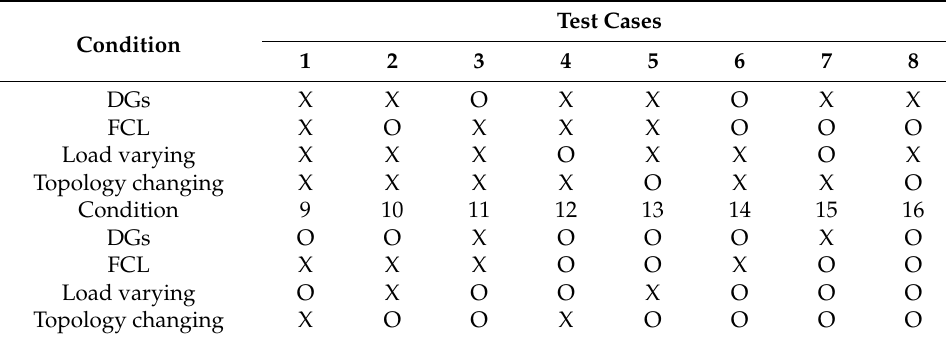
Table 1. Sixteen conditions considered for system